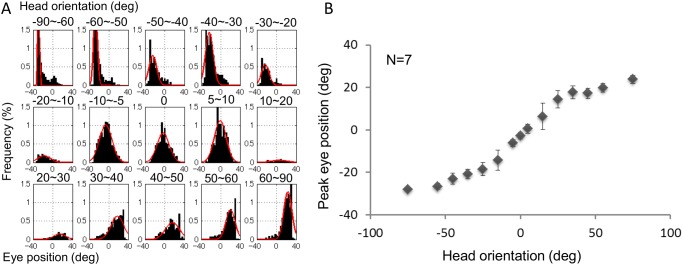
Influence of head orientation on eye position distribution.(A) Distribution of eye positions with different head orientations is shown in different panels. The horizontal head orientation is binned into 15 groups and eye position data are analyzed for each group. The range of head orientation for each group is shown at the top of each panel. The ordinate shows the percentage of fixations from all head directions and the abscissa shows horizontal eye position relative to the head. The red line shows a Gaussian function fitted by a least square method. (B) The average of the peaks of the Gaussian functions fitted to each data set from seven subjects as a function of head orientation. Error bars represent standard error.